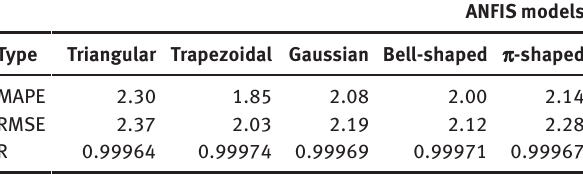
Table 10 Performance criteria of ANFIS models.